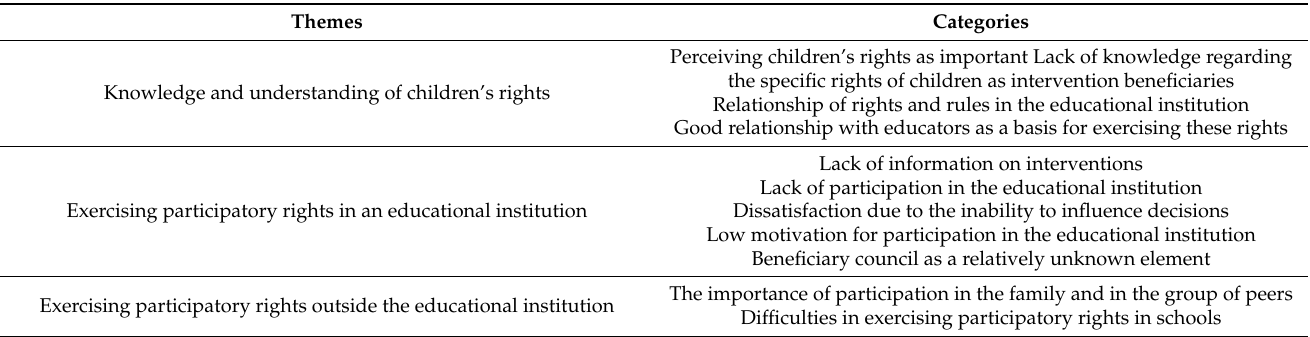
Table 1. Themes and